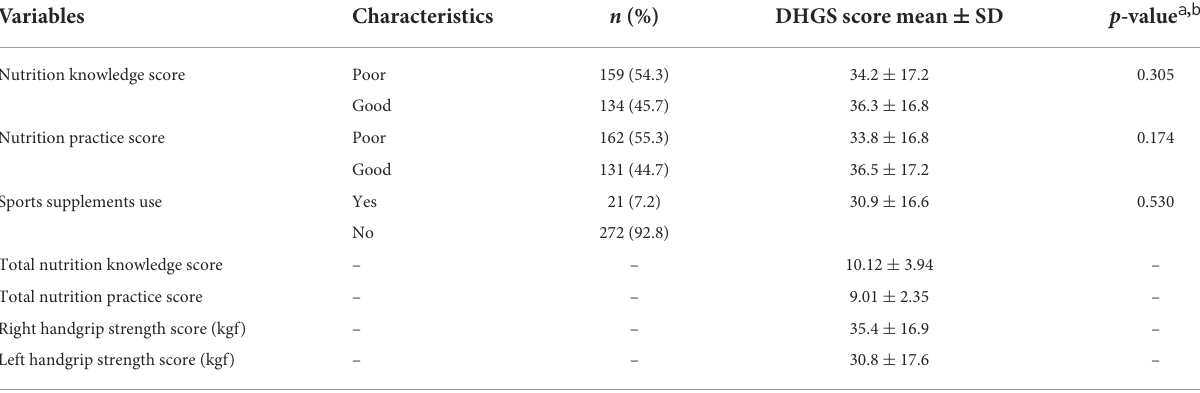
TABLE 2 Nutrition related information of study participants with dominant hand grip strength ( n = 293). Variables